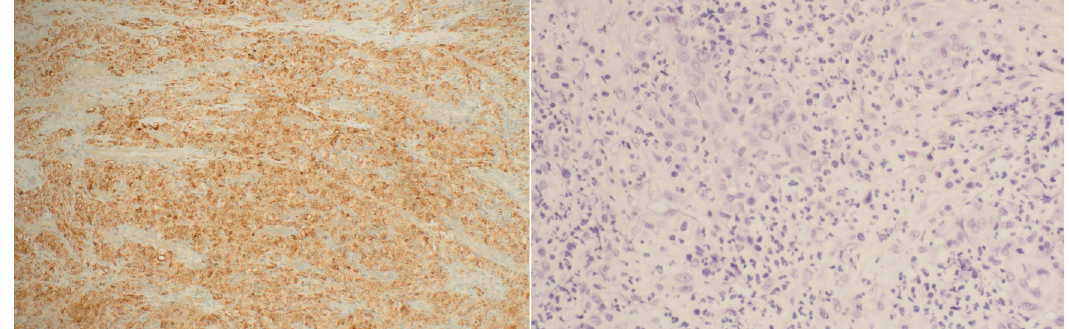
Fig. 3. Views of the lesion with HES and immunohistochemistry with CD68 marking, showing foamy macrophages within a fi brous stroma. Cells are